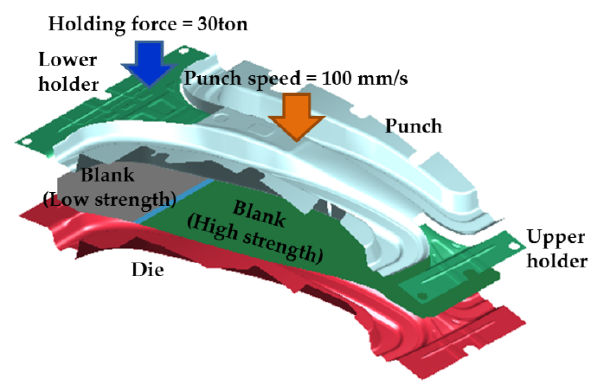
Figure 3. FE model of hot stamping process for center pillar manufacture. Table 1. Conditions of FE simulation for hot stamping process [17].